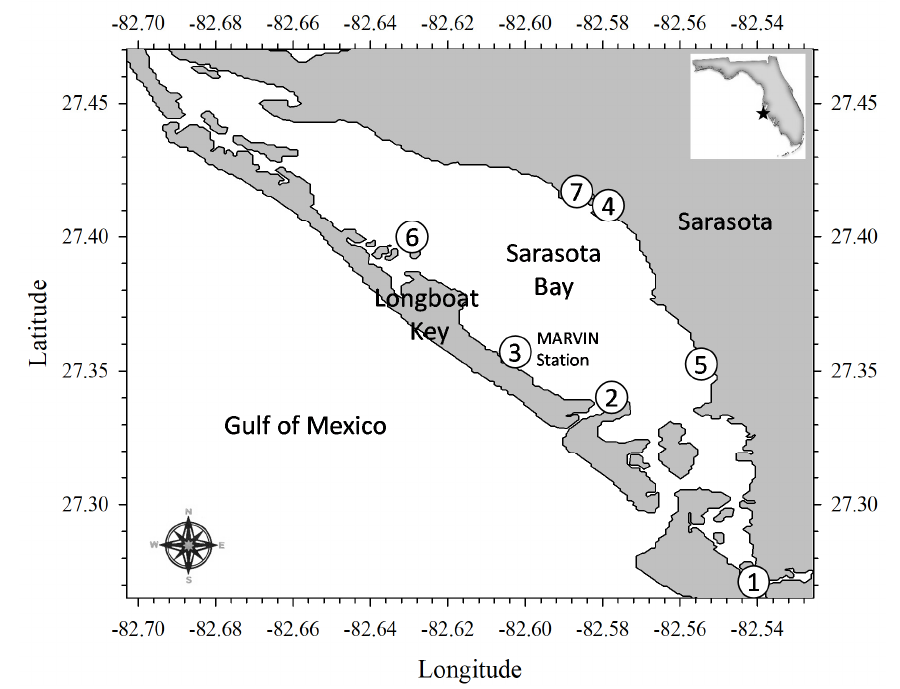
Figure 1. Map of Sarasota Bay showing the autonomous platform (MARVIN) station mooring site (Station 3) and six additional stations monitored throughout the study.